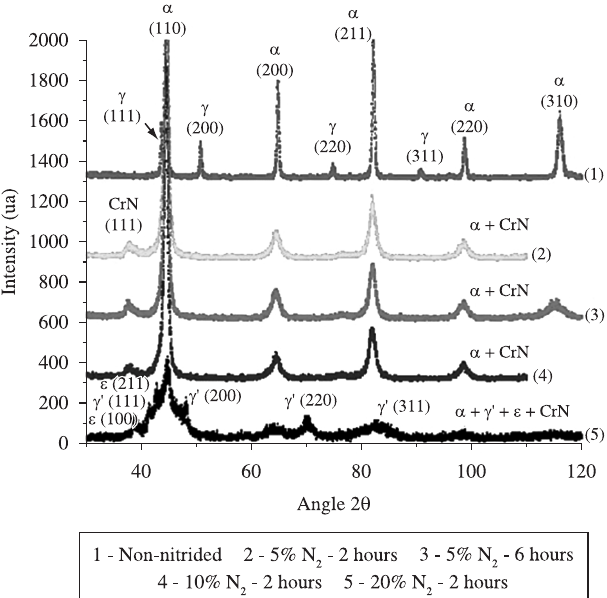
Figure 6. X-ray diffraction patterns for plasma nitrided CA-6NM stainless steel surfaces in different